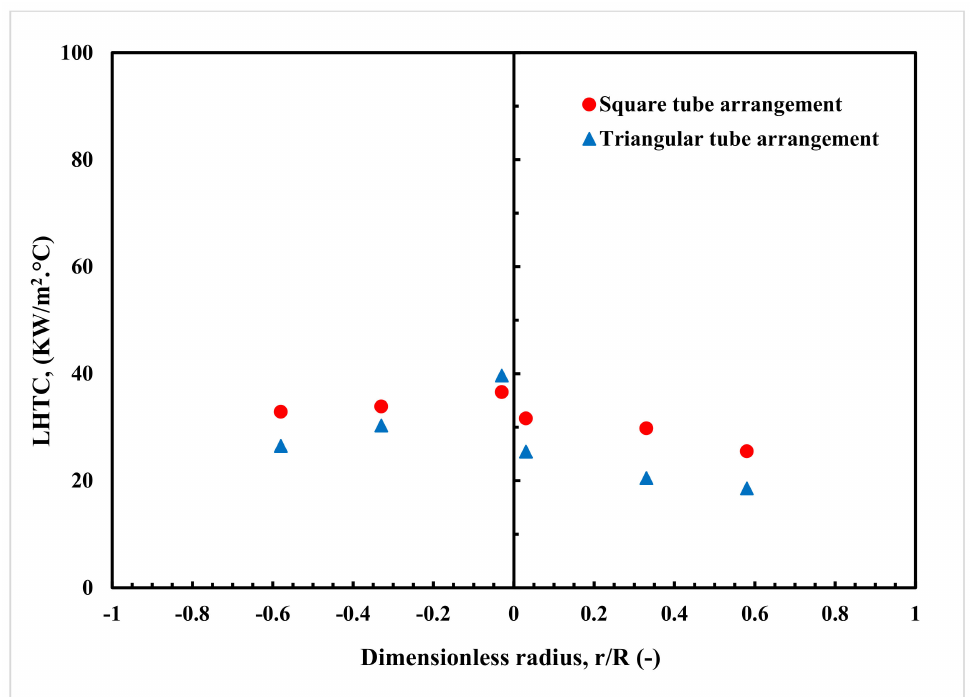
Figure 7. LHTC profiles measured at the axial level of 65 cm and an operating gas velocity of 0.05